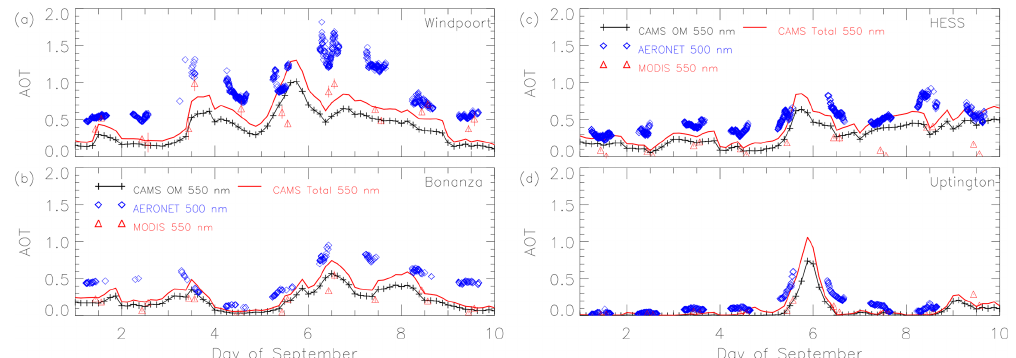
Figure 8. Time evolution of AERONET Sun-photometer-derived total AOT at 500nm (blue diamonds), MODIS AOT at 550nm from Terra and Aqua (red triangles) and CAMS-derived total AOT (red solid line) and organic matter AOT at 550nm (solid black line with black crosses) over (a) Windpoort, (b) Bonanza, (c) the HESS site and (d) Upington from 1 to 10 September 2017. A robust linear relationship is observed between the natural logarithm of the AOT at 500 and 550nm (see Denjean et al., 2020, and Gaetani et al., 2021); therefore, CAMS and MODIS products at 550nm can be used as reliable proxies for the AOT at 500nm at the AERONET